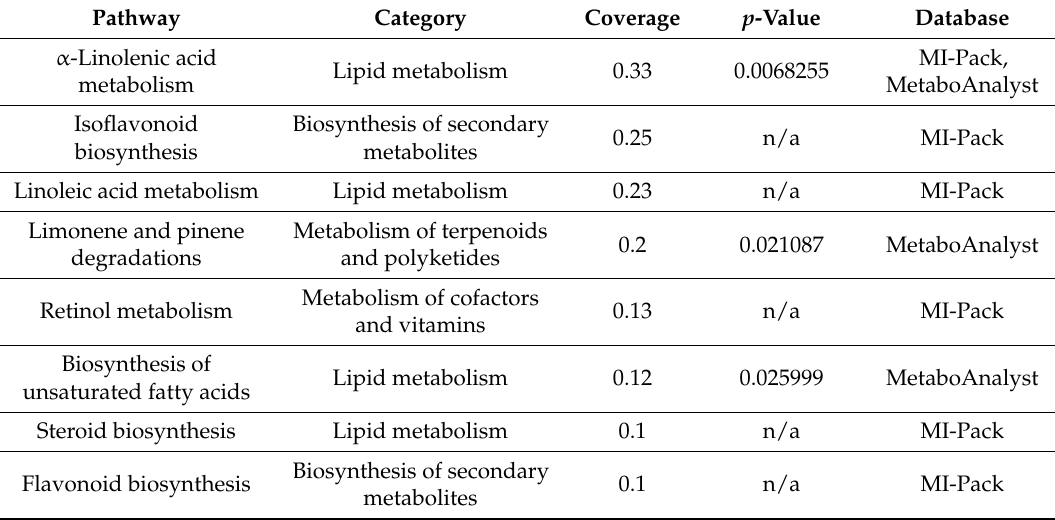
Table 1. Major metabolic pathways significantly involved in drought stress response of thyme